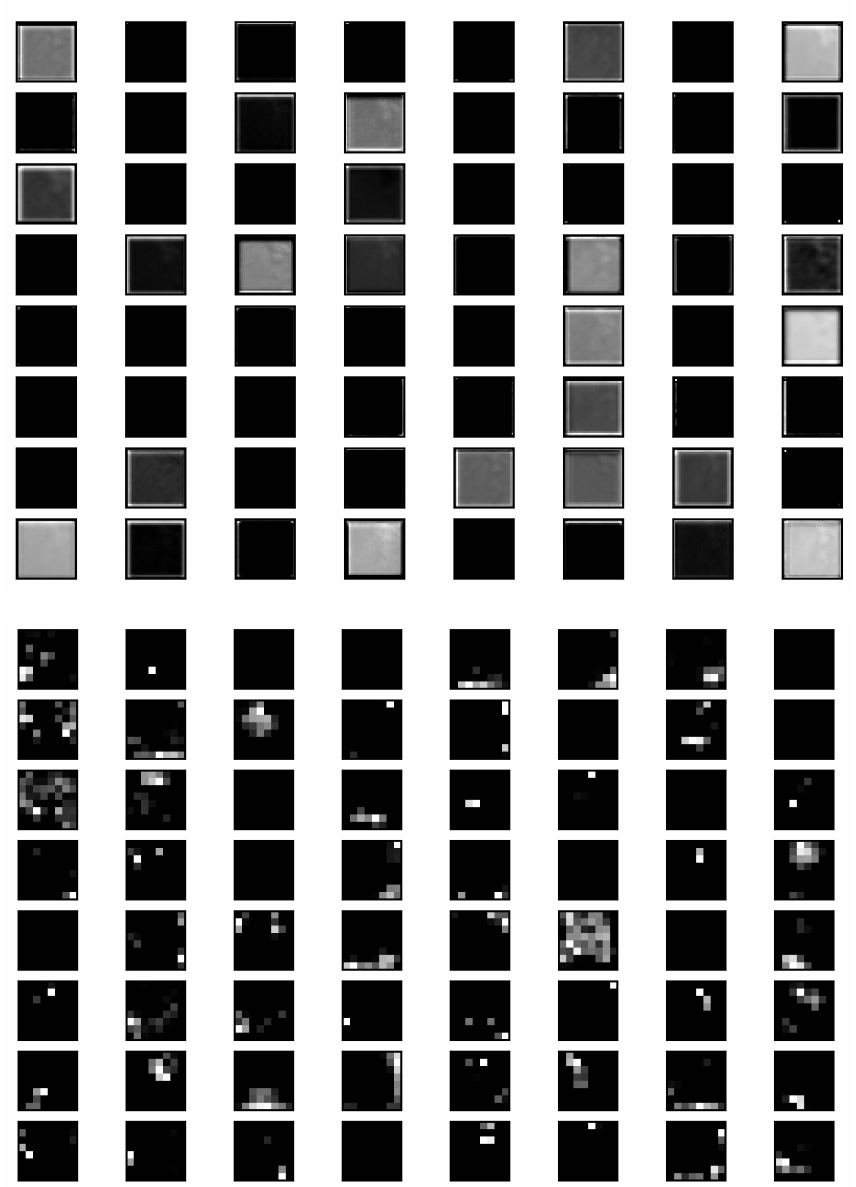
Figure 4. Feature map of learned features on the first two